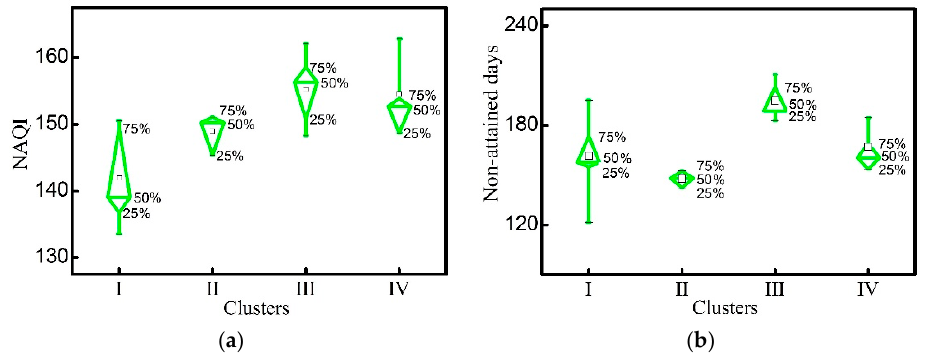
Figure 8. Diamond box plot of the NAQI ( a ) and non-attainment days ( b ) based on the dendrogram. The bottom and top of the green box represent the 25th and 75th percentile, and the bottom and top black line represent the minimum and maximum value, respectively. The hollow square represents the mean value.